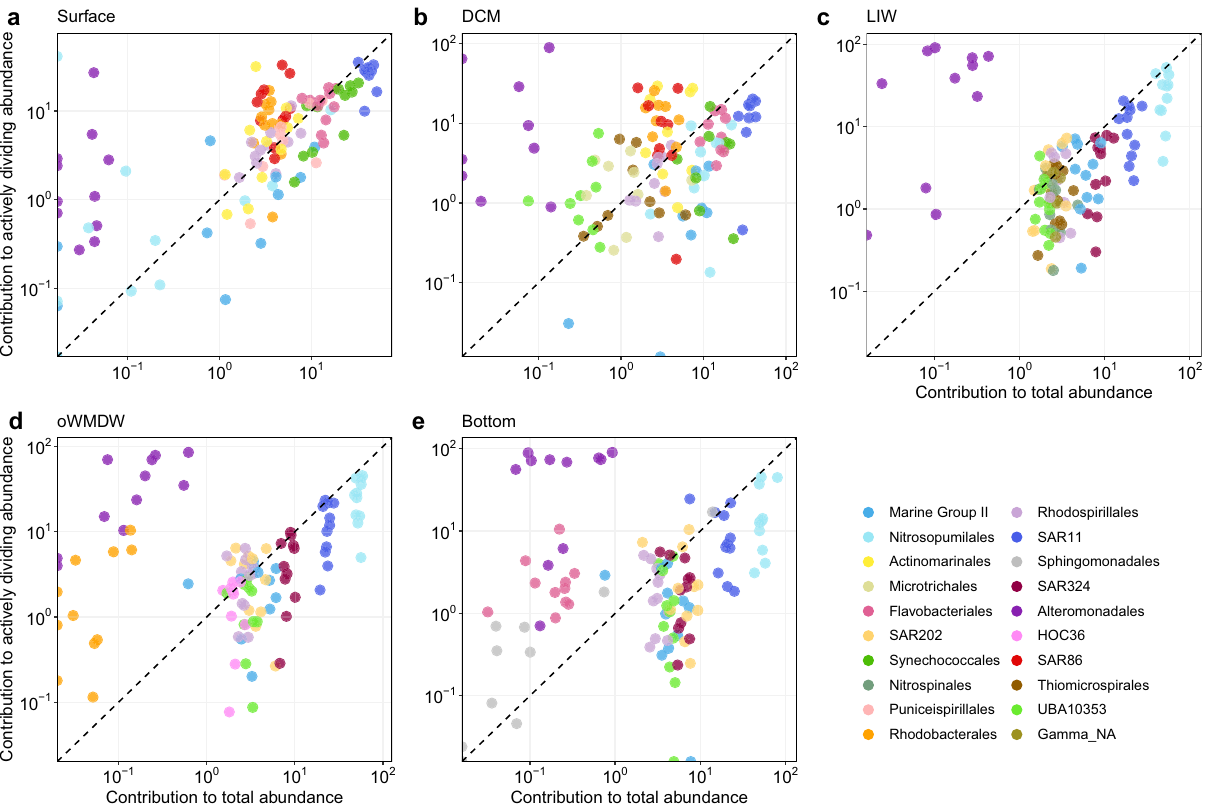
Figure 3. Relative contribution of phylotypes to total vs. actively dividing communities. Phylotypes at the Order level with > 1.5% of abundance are plotted for ( a ) surface, ( b ) deep chlorophyll maximum (DCM), ( c ) Levantine intermediate water (LIW), ( d ) old western Mediterranean deep water (oWMDW) and ( e ) bottom. Dashed lines indicate equal contribution to total and actively dividing communities, phylotypes above the line contribute more to the actively dividing community than to the total community. NA: